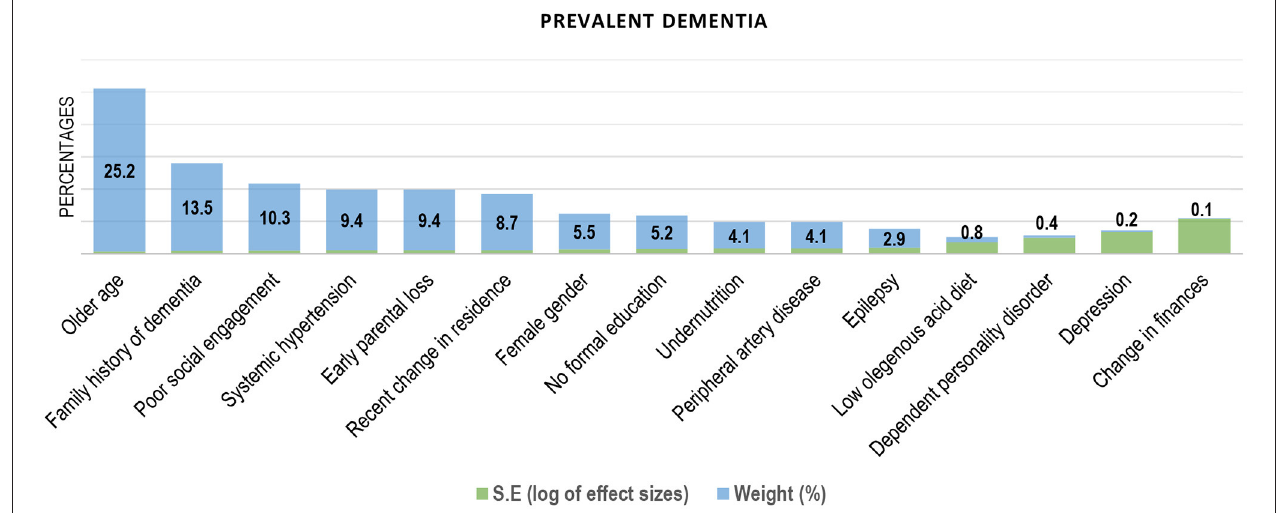
FIGURE 3 | Factors associated with prevalent dementia in Sub-Saharan Africa (ranked by the inverse of variance method).